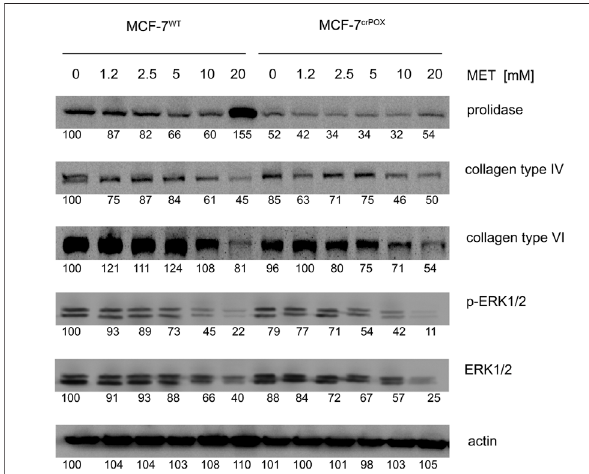
FIGURE 4 | Western blot for prolidase, collagen types IV and VI, and ERK1/2 in wild-type MCF-7 cells (MCF-7 WT ) and knocked-down PRODH/ POX MCF-7 cells (MCF-7 crPOX ) treated with metformin (MET, 0 – 20 mM) for 48 h in glutamine-free medium. Representative blot images are shown (the mean value of the densitometric analysis of protein bands is presented below each blot).